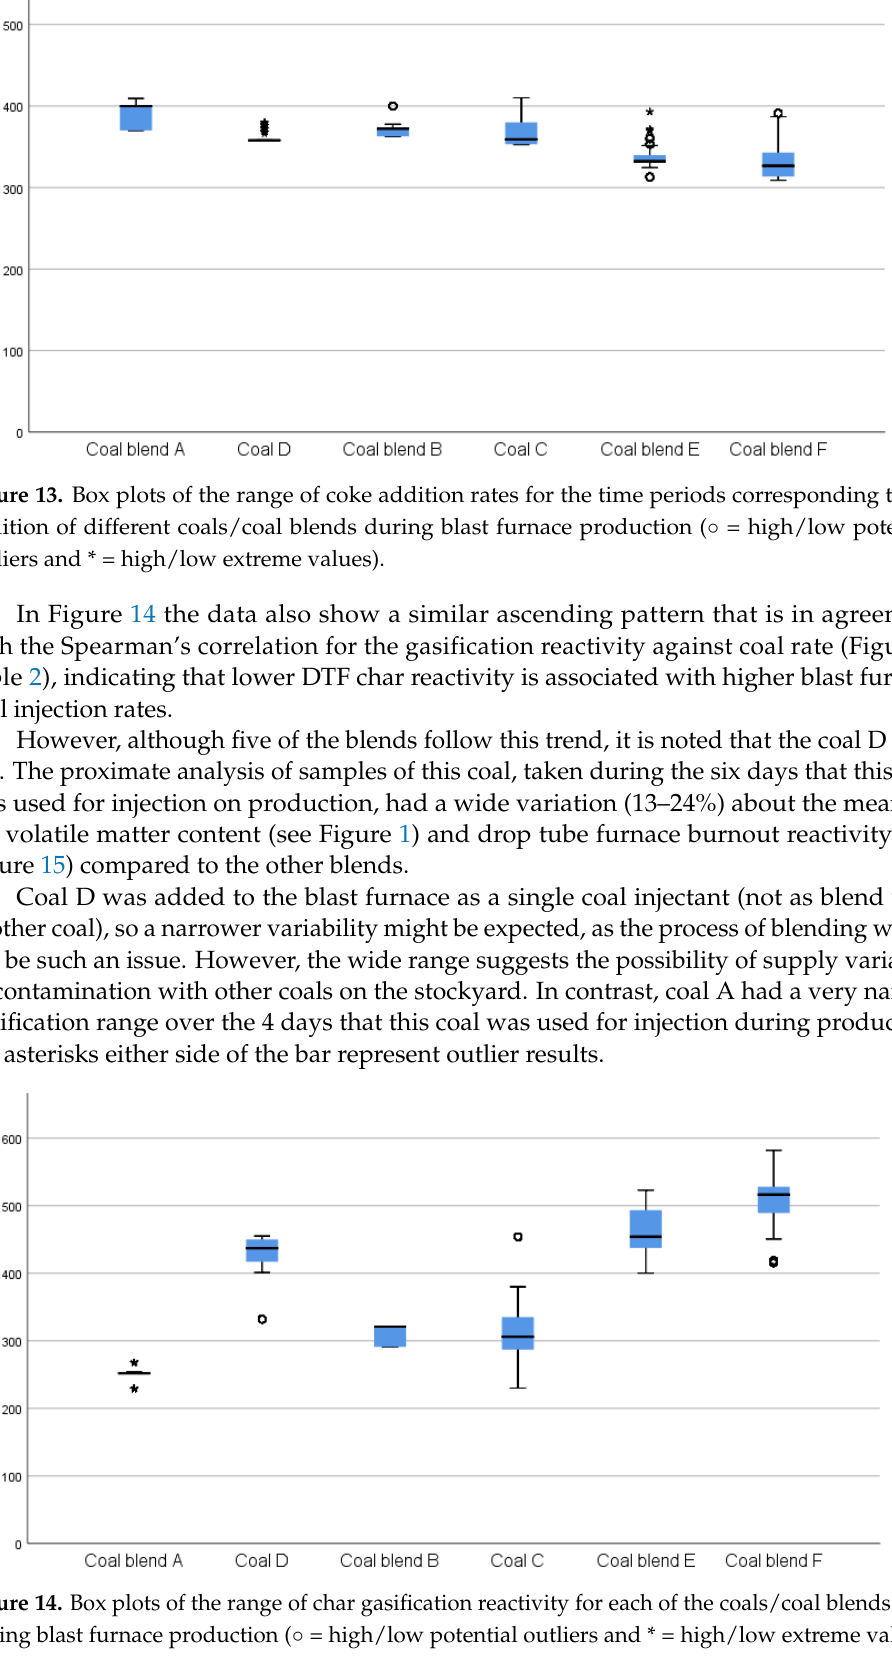
Figure 14. Box plots of the range of char gasification reactivity for each of the coals/coal blends used during blast furnace production (◦ = high/low potential outliers and * = high/low extreme values).